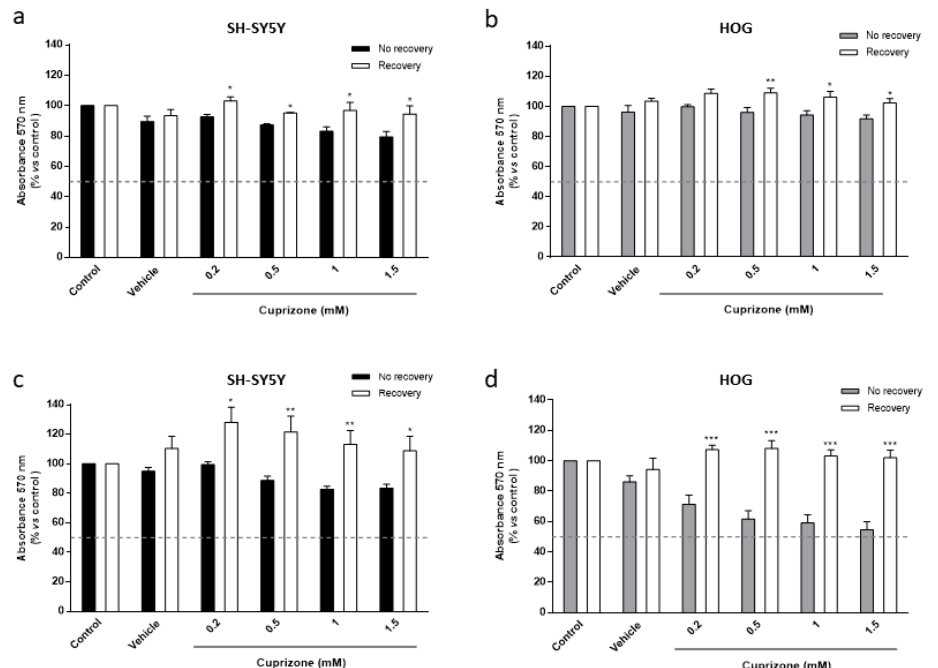
Figure 3. MTT reduction assay in SH-SY5Y ( a , c ) and HOG ( b , d ) cells treated with increasing con- centrations of CPZ (0.2–1.5 mM) for 24 h followed by 24 ( a , b ) or 48 h ( c , d ) without the treatment (recovery period). Cell damage is represented as the percentage of MTT reduction versus control. Data are the mean ± S.E.M of five independent experiments. Significant differences were analyzed by a two-way ANOVA followed by post-hoc Tukey’s test. * p < 0.05, ** p < 0.01, *** p < 0.001 compared to no recovery.